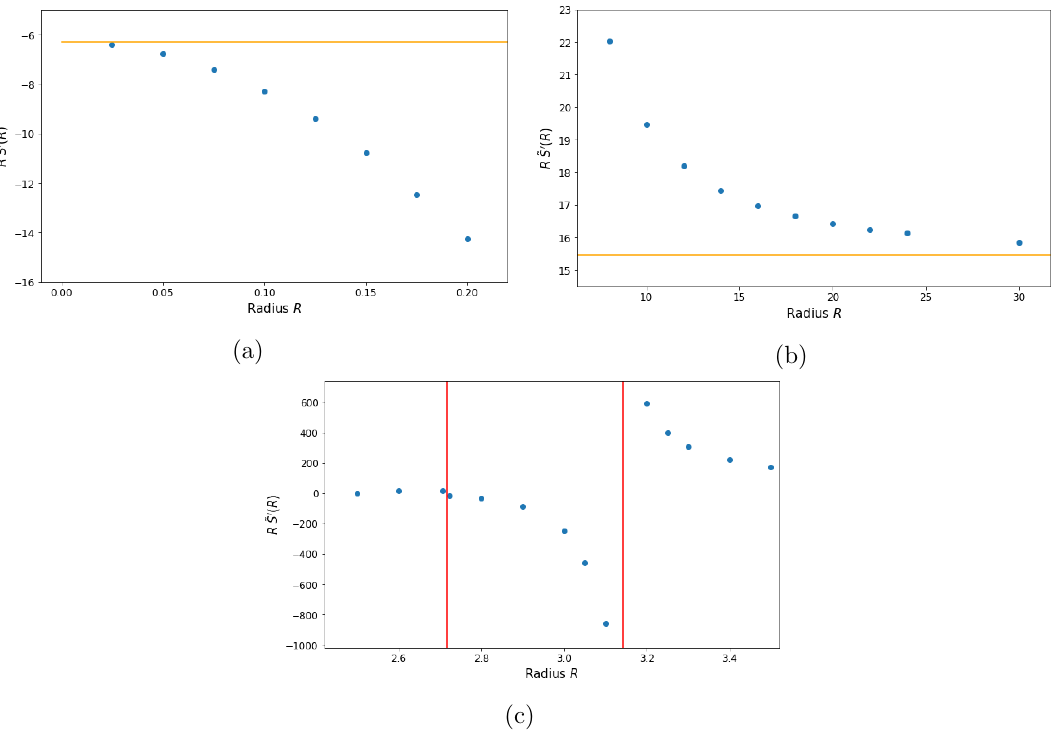
Figure 12. Evolution of R ˜ S 0 ( R ) for N = 4 SYM on S 2 . Graphs (a) and (b) show the behavior for small and large entangling radius R , respectively. The interpolating function matches the expected values in the UV and IR (orange segments). Graph (c) shows the behavior in an intermediate range where the function has discontinuities. The red vertical lines mark out the appearance of the bridge at R ≈ 2 . 72 and the corners at R = π